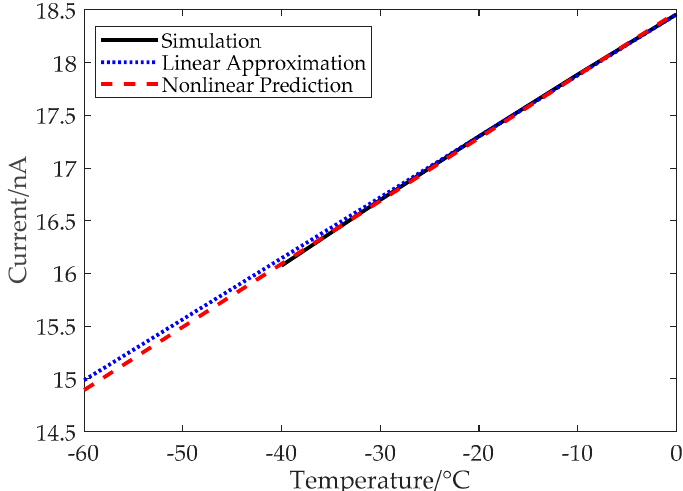
Figure 3. The simulated I 0 vs. the temperature, the linear approximation of I 0 , and the hyperbolic prediction from (12).